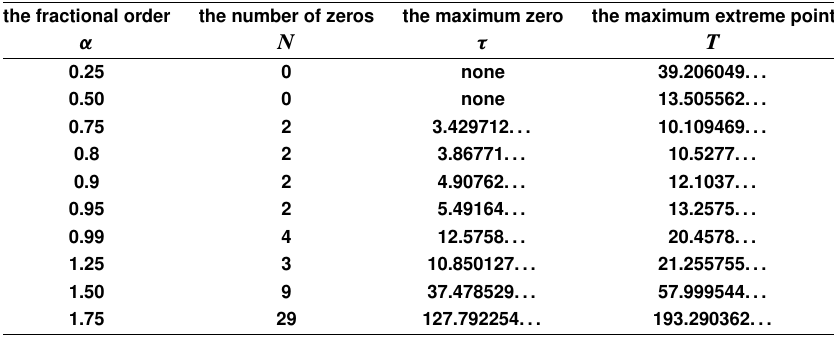
Table 2. The number of zeros, the maximum zero and the maximum extreme point of y.t/ for b D c D 1 and different ˛ . the fractional order the number of zeros the maximum zero the maximum extreme point ˛ N (cid:28) T 0.25 0 none 39.206049... 0.50 0 none 13.505562... 0.75 2 3.429712...